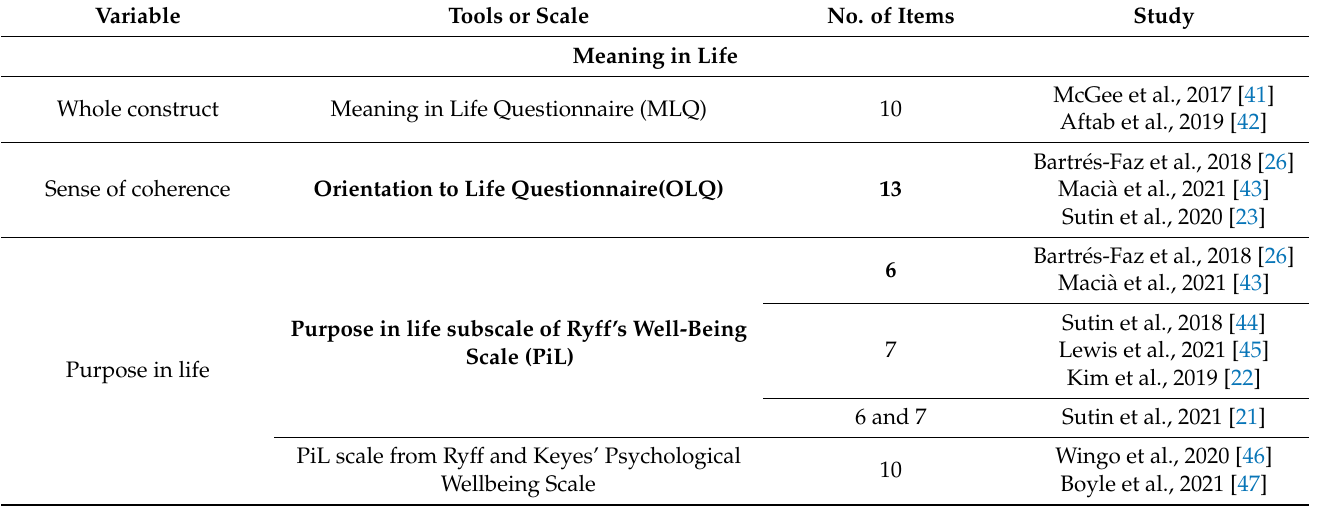
Table 2. Summary of the tools or scales used in each